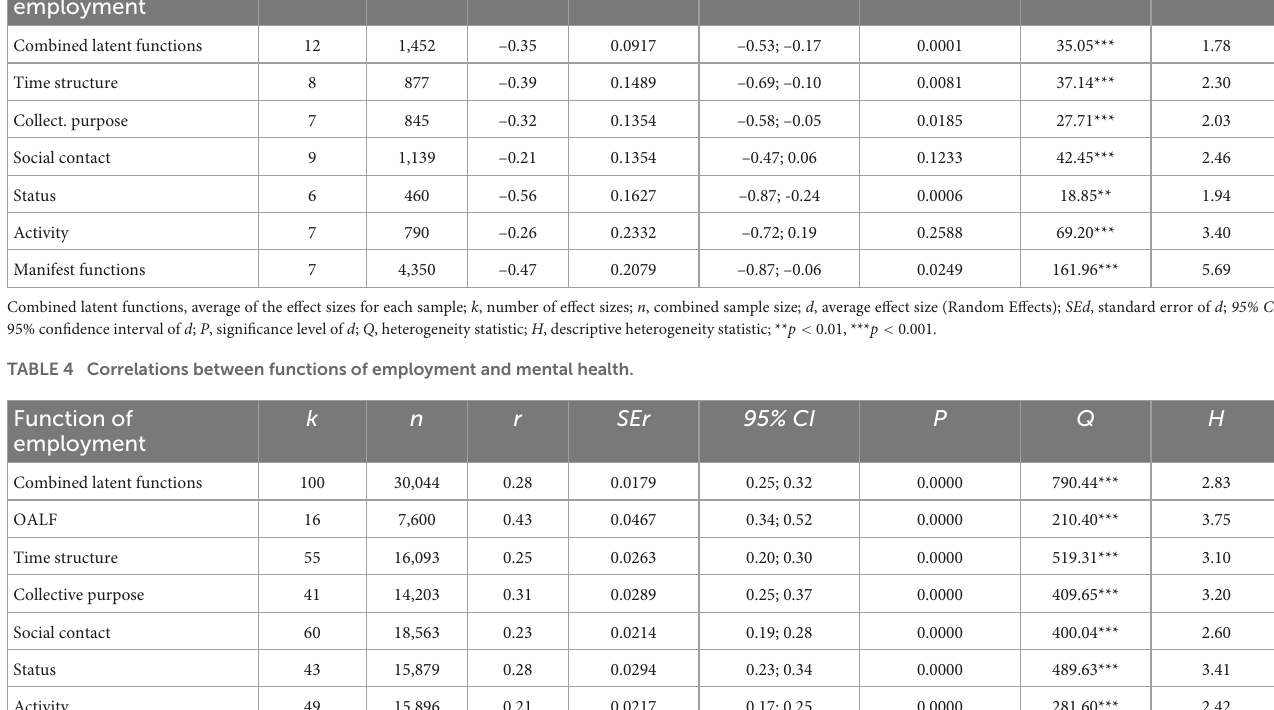
TABLE 3 Latent and manifest functions of employment–differences between unemployed persons and persons who are out of the labor force (OLF). Function of